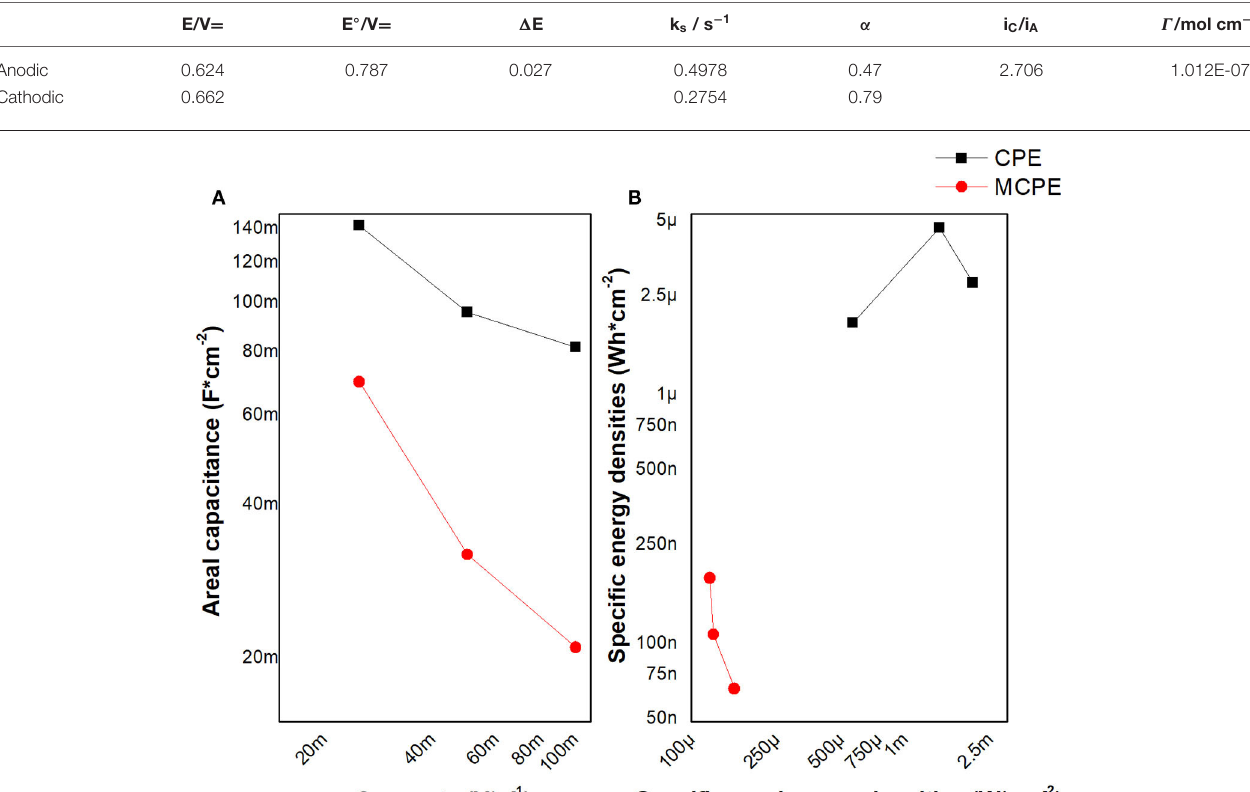
TABLE 1 | Thermodynamic values and modeled kinetic parameters using Laviron equation adjustment.